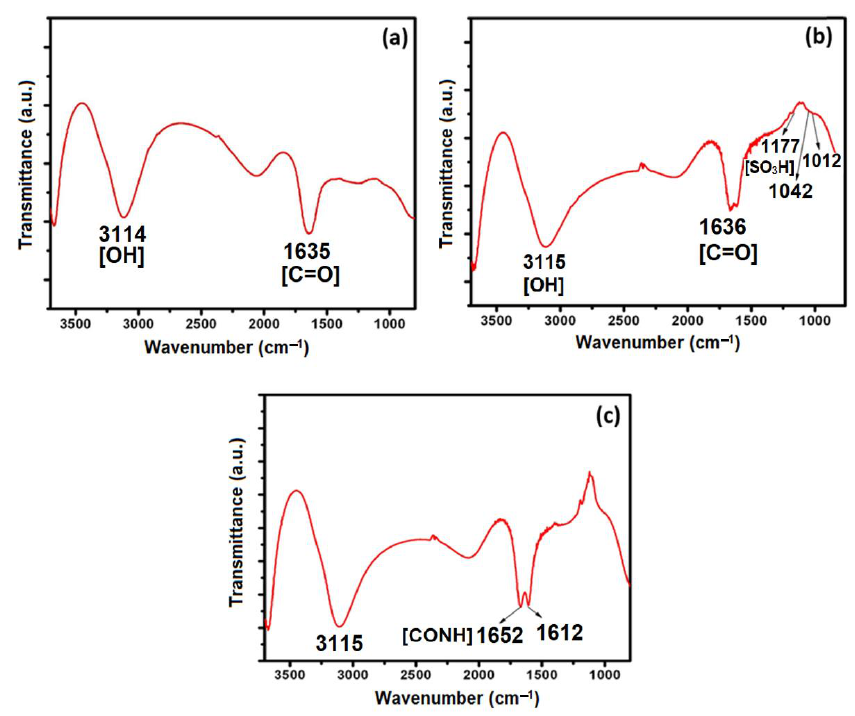
Figure 4. FT-IR spectrum of ( a ) GO-COOH, ( b ) GO-SO 3 H, and ( c ) FA-GO-SO 3